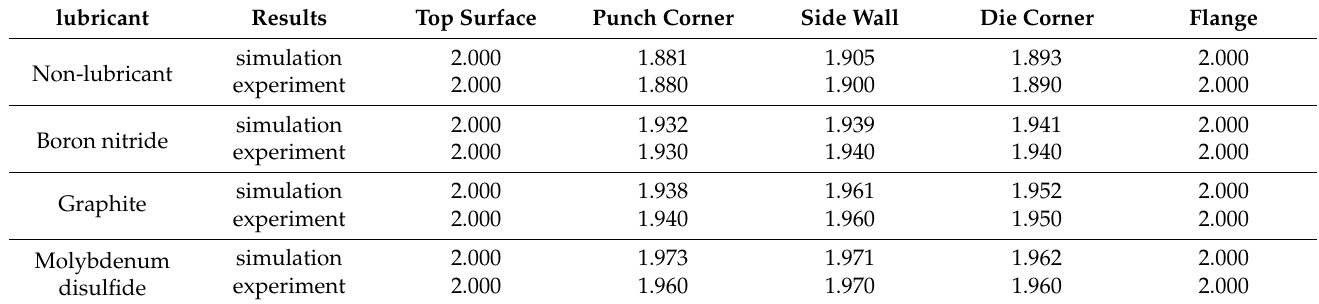
Table 6. Average thickness distribution of parts for experiments and simulations (mm).